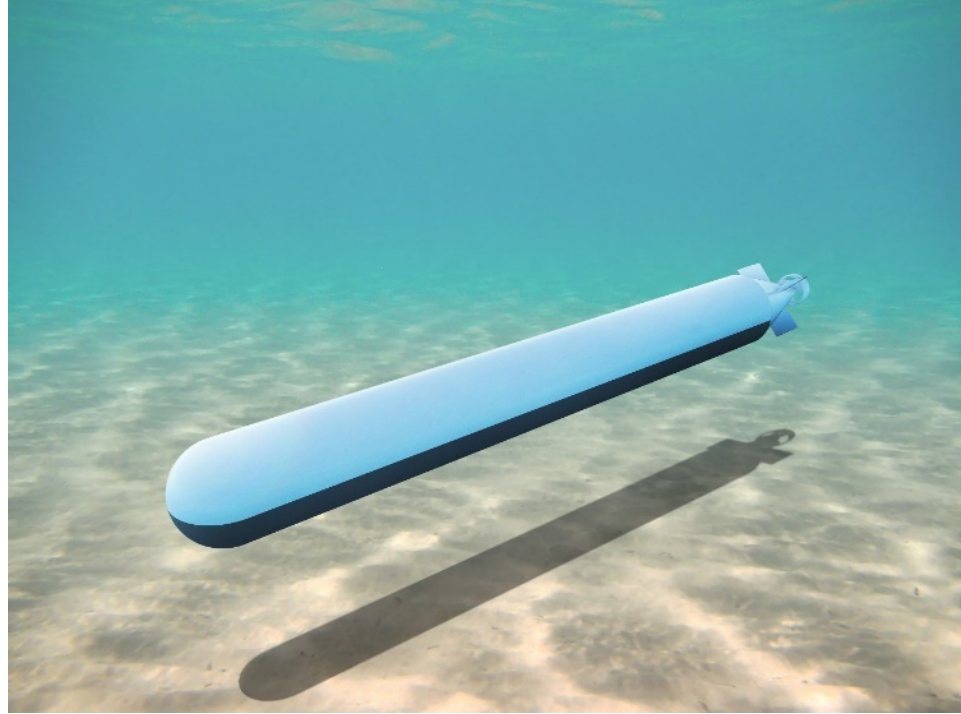
Figure 1. Illustration of the Subsea Shuttle Tanker [8].